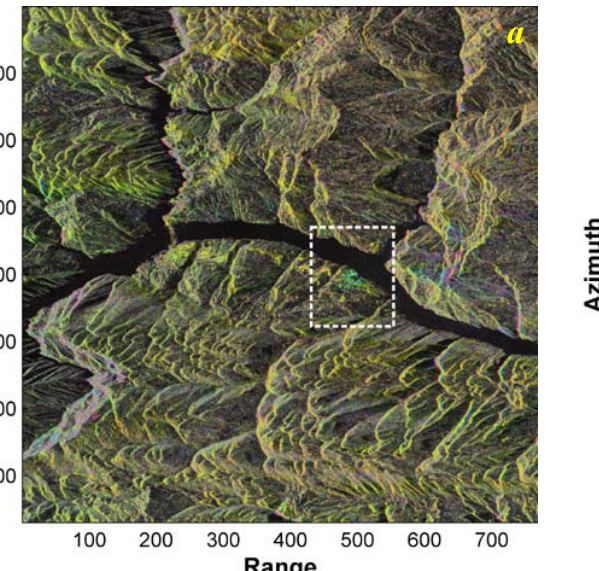
= 156 m), ( b ) Interferogram of n = 47 m) and ( c ) Interferogram of n = 97 m). The white n